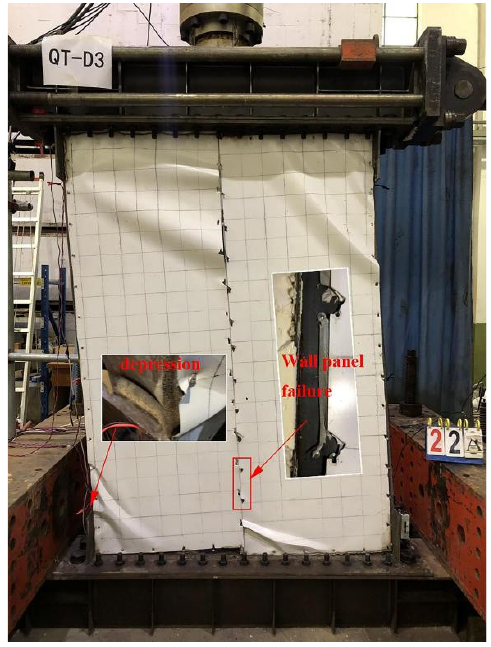
Figure 8. Failure image of QT − D3.